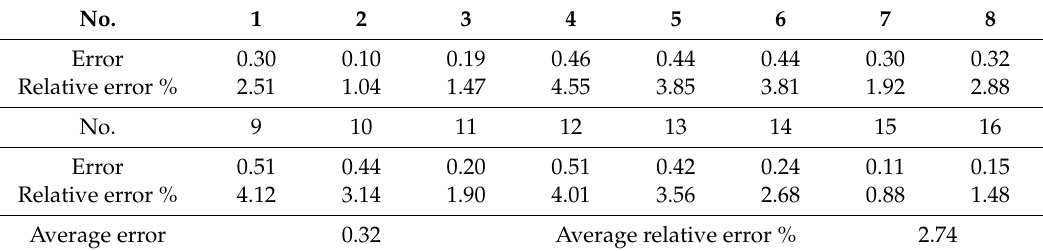
Table 6. Prediction error of M 2 .